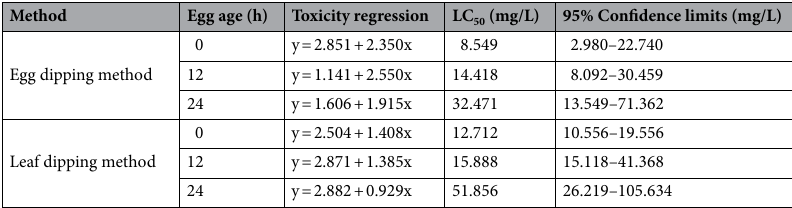
Table 1. Toxicity of spirotetramat to F. occidentalis eggs .